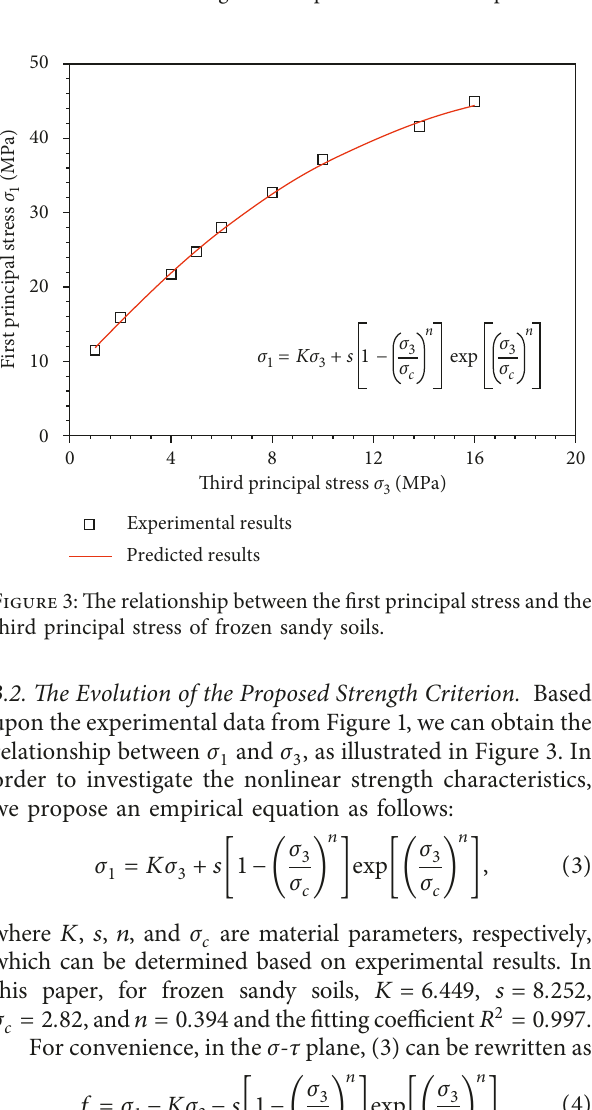
Figure 2: The strength envelope in the meridian plane.